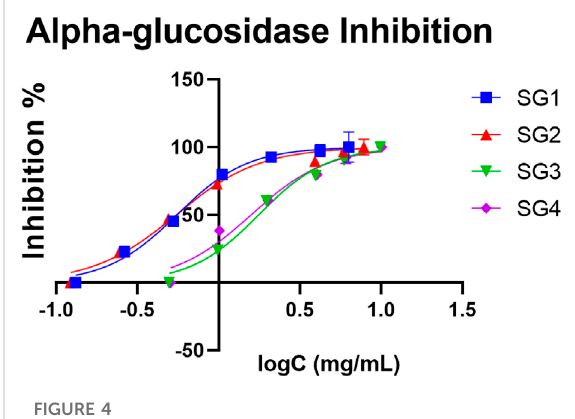
FIGURE 4 The concentration (expressed as logC, in mg/mL) dependent inhibition effect of S. glutinosa extracts on yeast α -glucosidase. The IC 50 for acarbose was 0.239 mg/ml. Each point indicates average ±SD (standard deviation) of three parallel